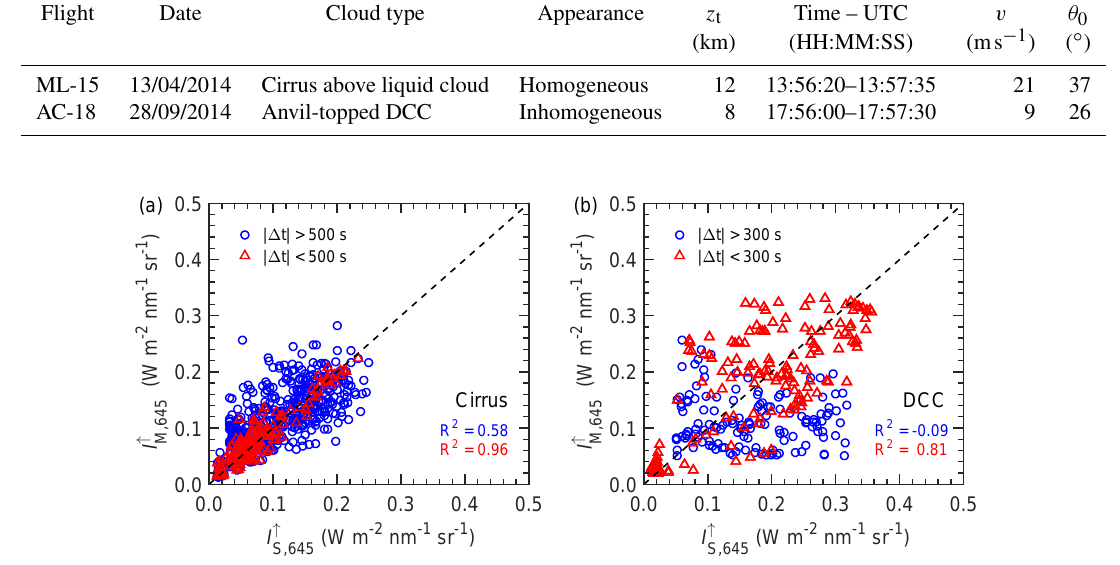
Figure 2. Scatter plots of upward radiance at λ = 645nm measured by SMART ( I for the cirrus (a) and 300s the DCC (b) . Blue circles and red triangles represent data within and without the predetermined threshold. The dashed line represents the one-to-one